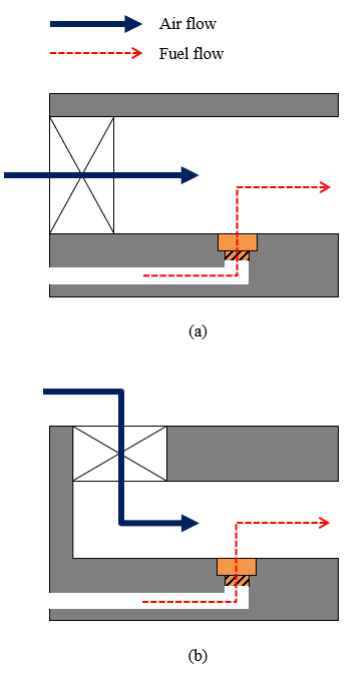
Figure 1. Comparison of the jet in crossflow with two types of swirlers: ( a ) cross-section of jet in axial swirler; ( b ) radial swirler.